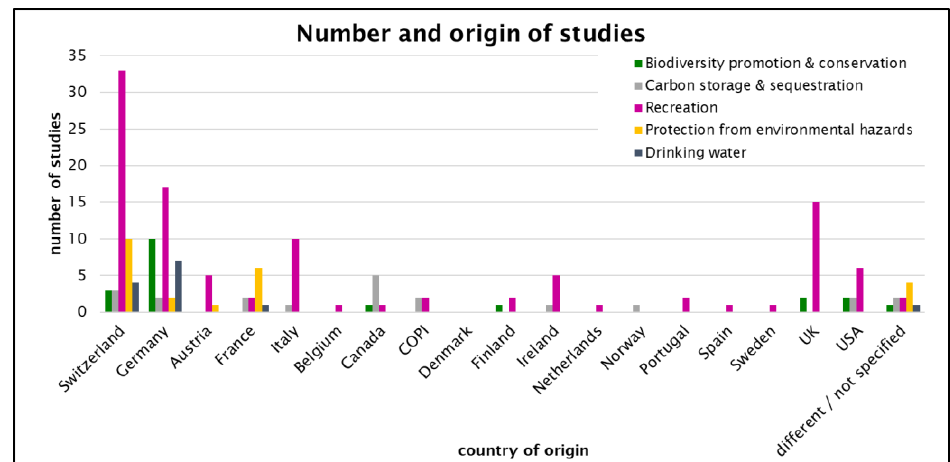
Figure 4. Overview of number and origin of the database's valuation studies.